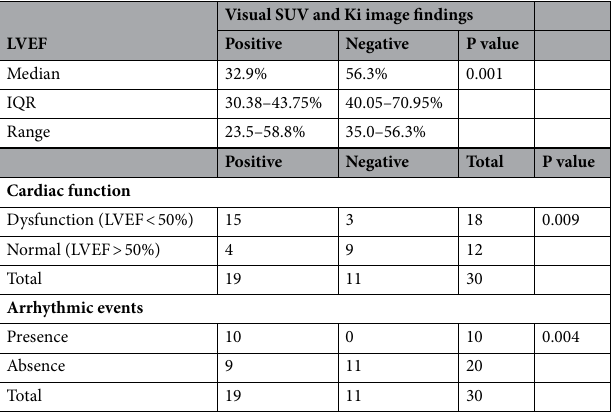
Table 1. Relationships between visual SUV or Ki myocardial findings and clinical events in 30 18 F-FDG PET/ CT Scans of 21 patients with cardiac sarcoidosis. LVEF left ventricular ejection fraction, IQR interquartile